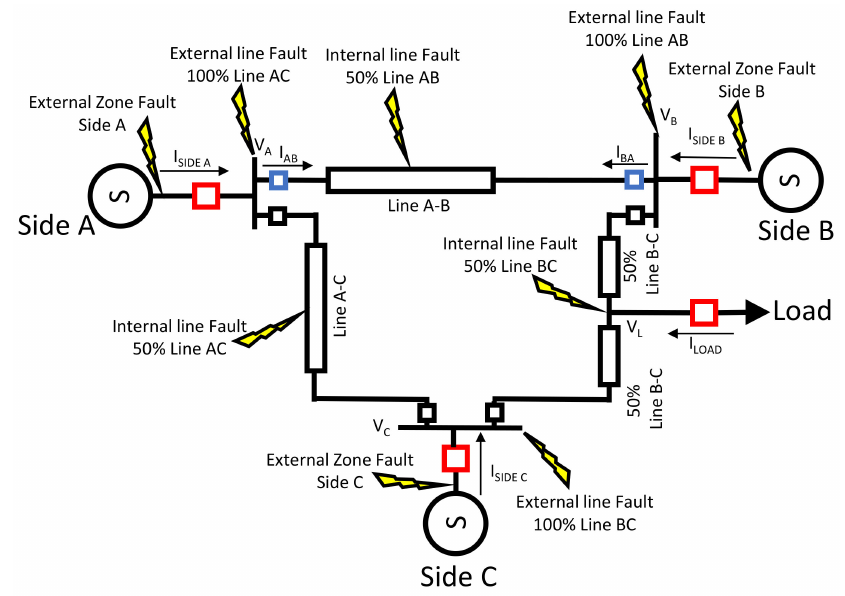
Figure 10. Fault locations in the transmission